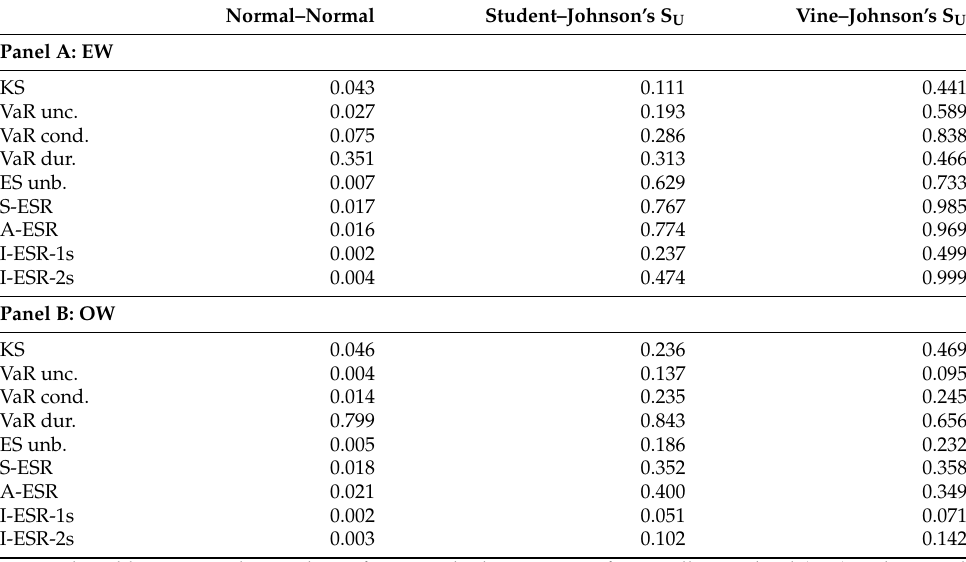
Table 3. Statistical adequacy of portfolio